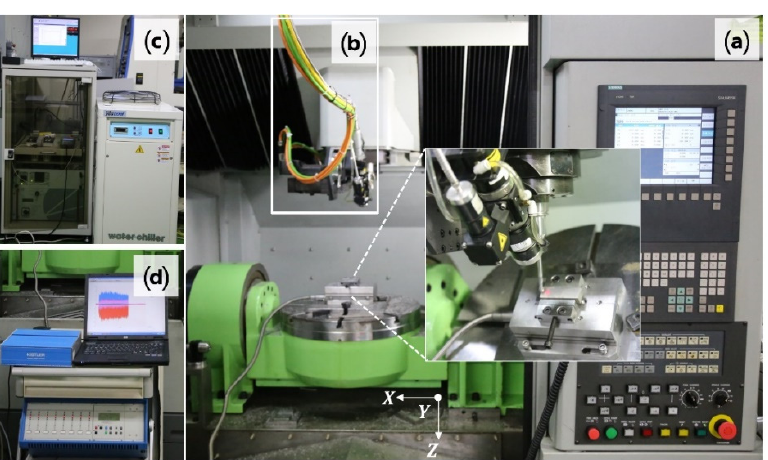
Figure 3. Experimental set-up: ( a ) CNC milling machine; ( b ) fiber-coupled high-power diode laser; ( c ) laser controller; ( d ) dynamometer.